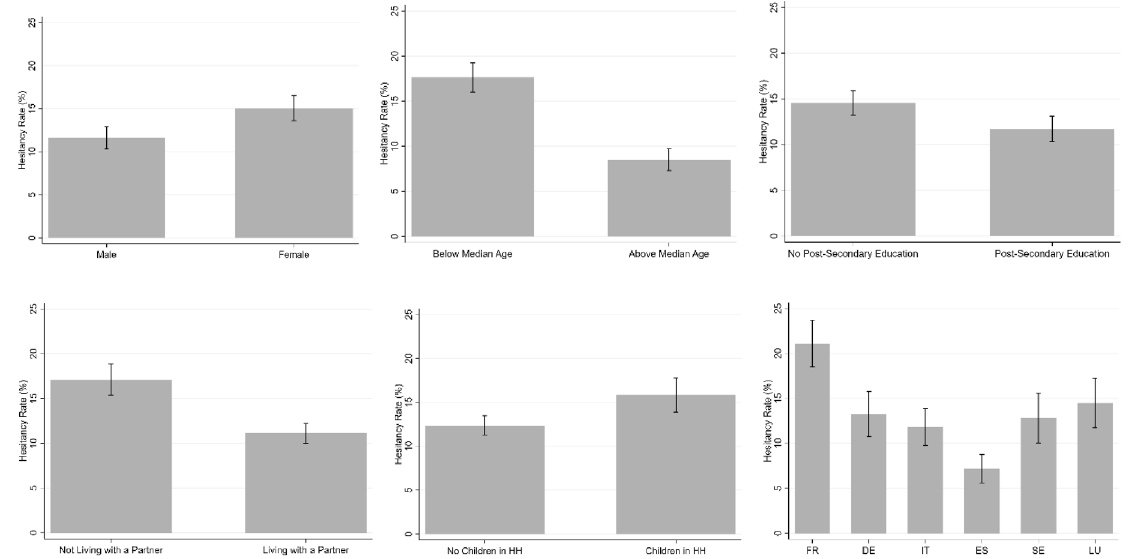
Figure 1. Vaccine hesitancy: demographic groups and countries. Notes : These figures refer to our estimation sample. The grey bars show the percentage of vaccine-hesitant in each group, and the intervals refer to the 95% confidence intervals.